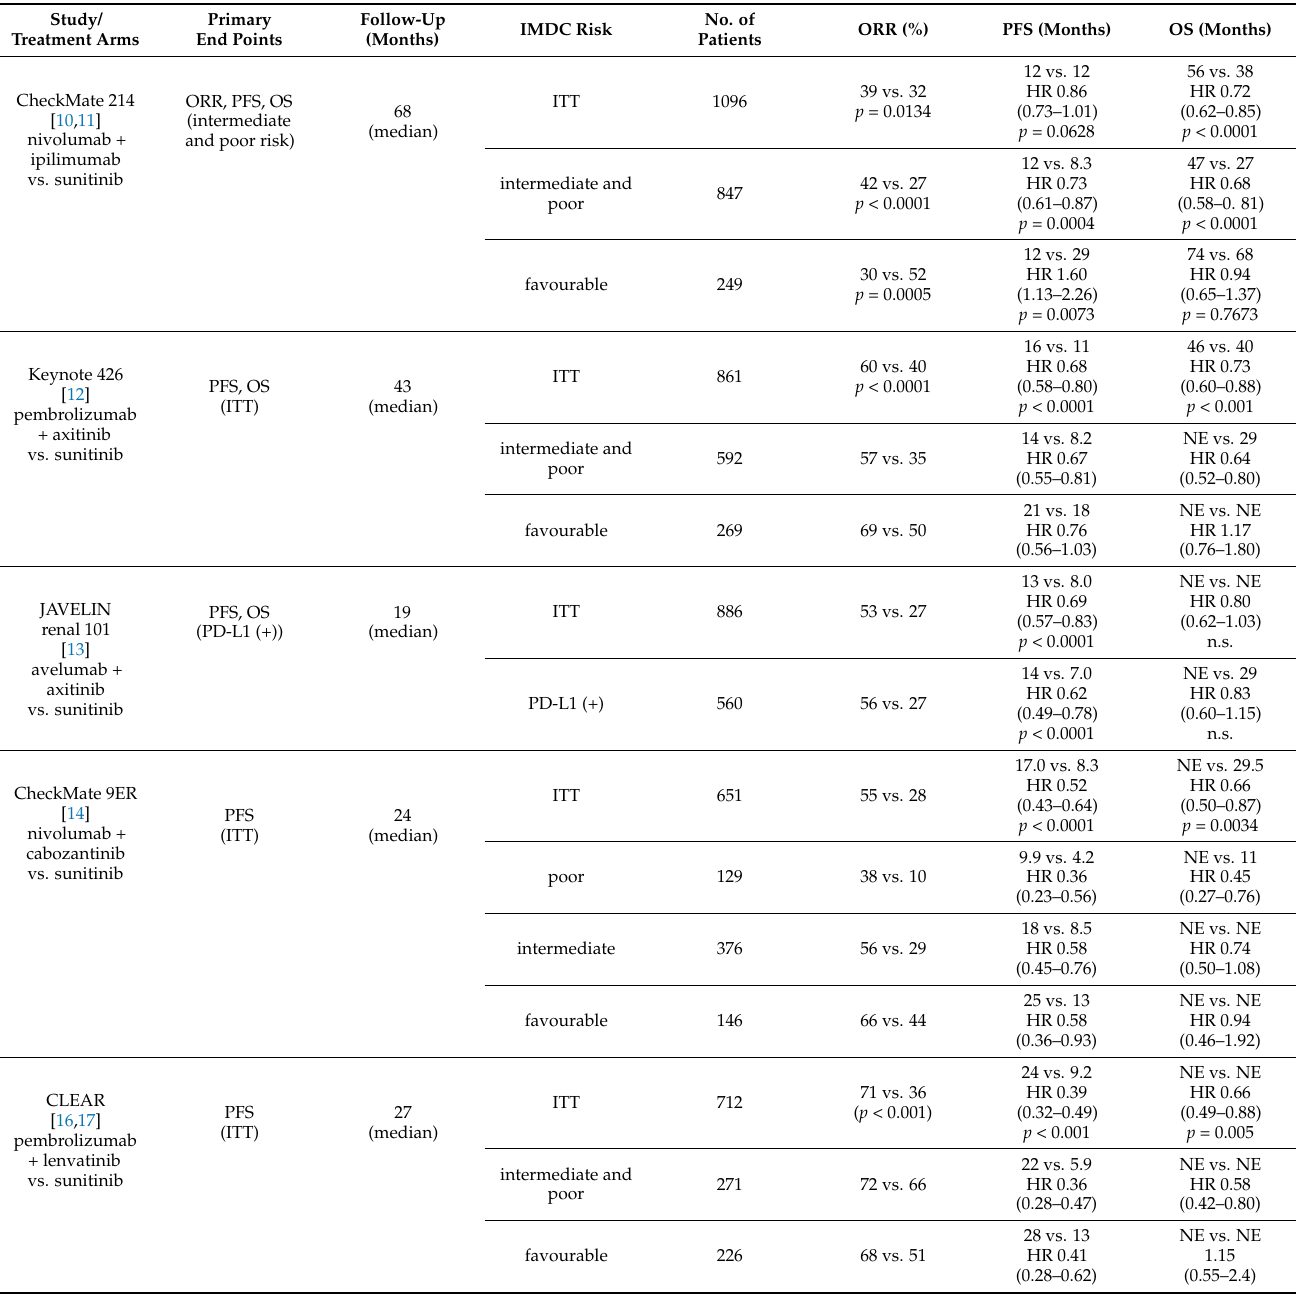
Table 1. Results of pivotal trials for combination therapies with PD-(L)1 immune checkpoint inhibitors (vs. sunitinib) for first-line treatment of advanced or metastatic renal cell carcinoma plus newly published data pembrolizumab + lenvatinib. Study/ Treatment